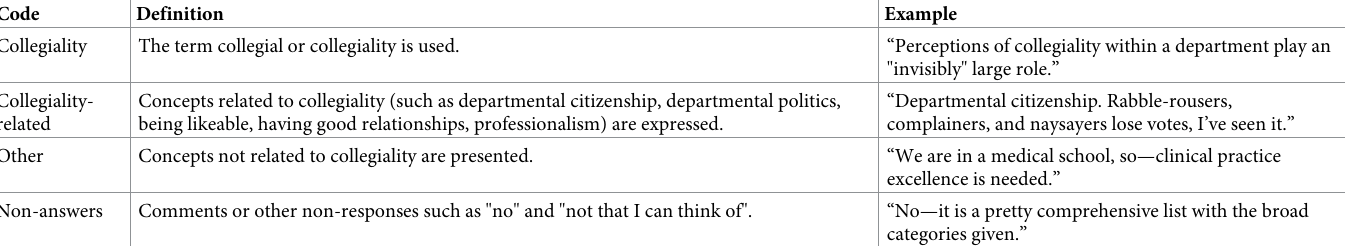
Table 1. Codes, definitions, and examples for the open-ended responses to this question in the survey: “Are there any other factors that you think are important for your review, promotion or tenure?”. Code